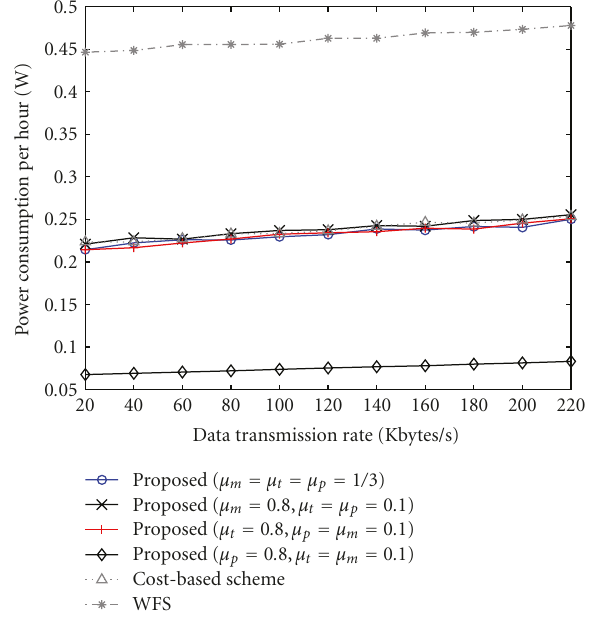
Figure 9: Data transmission rate versus power consumption per minute when the UDP tra ffi c ( ρ = 0) is generated.